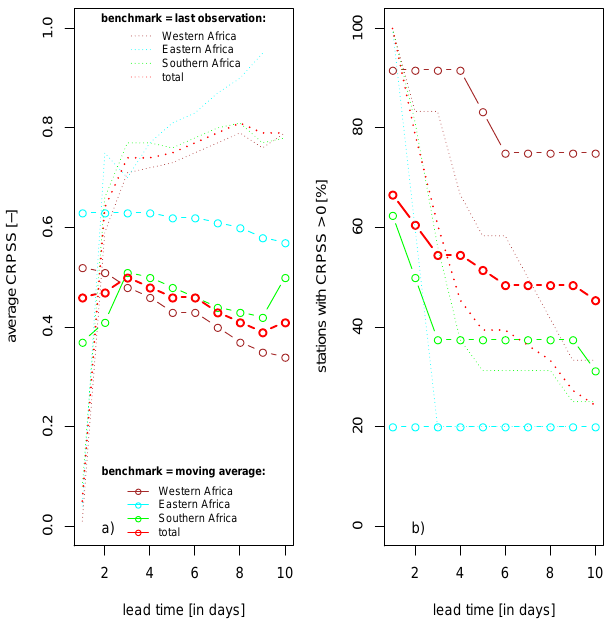
Figure 7. Continuous Rank Probability Skill Score (CRPSS) over the range of the 10-day lead time; (a) average CRPSS (only within the limit of predictability) and (b) number of stations with CRPSS >